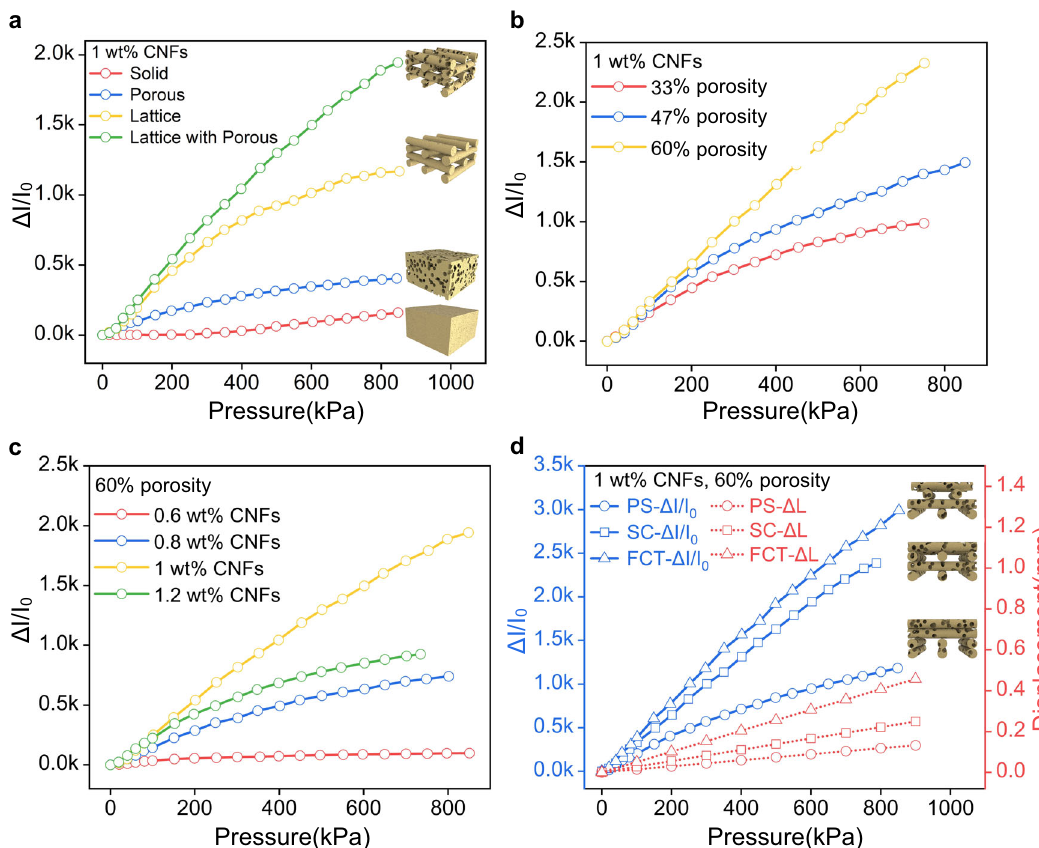
Fig. 2 Current response and sensitivity of HPPS with different parameters of sensing layer. a Current response and sensitivity of 1 wt% CNFs, 60% porosity pressure sensor with different geometrical structures (solid, porous, lattice, lattice with porous). Current response and sensitivity of four layers SC pressure sensor with different mass ratio of b water ( c ) CNFs. d Current response and sensitivity of 1 wt% CNFs, 60% porosity pressure sensor with different lattice structures (PS, SC and